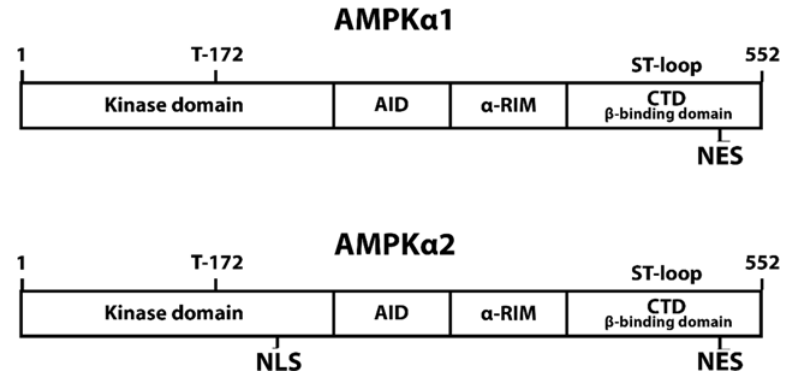
Figure 3. Localization-related sequences on AMPK α